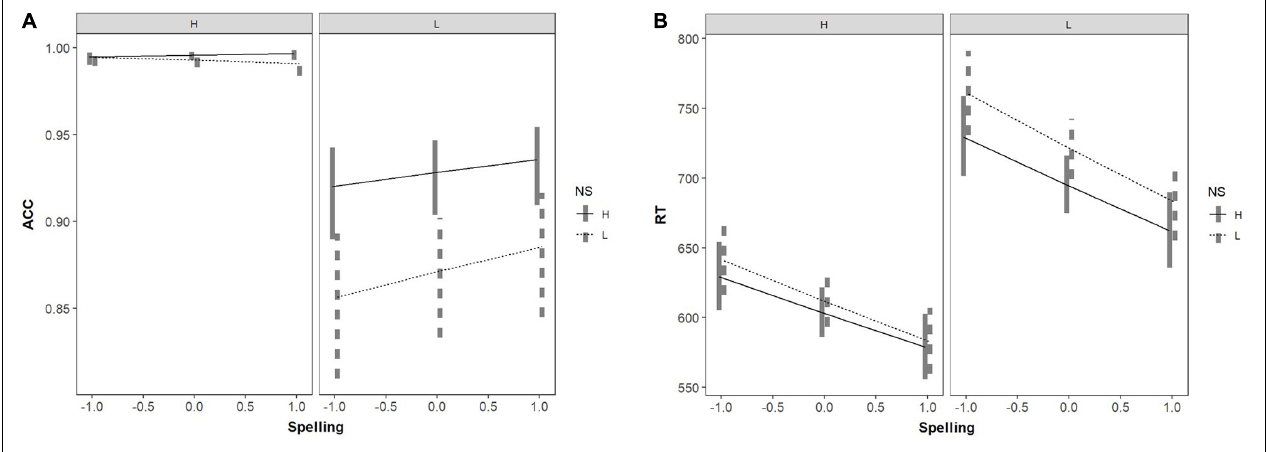
FIGURE 2 | Interaction among spelling skill and NS and WF in predicting (A) word recognition accuracy, and (B) word recognition response time.